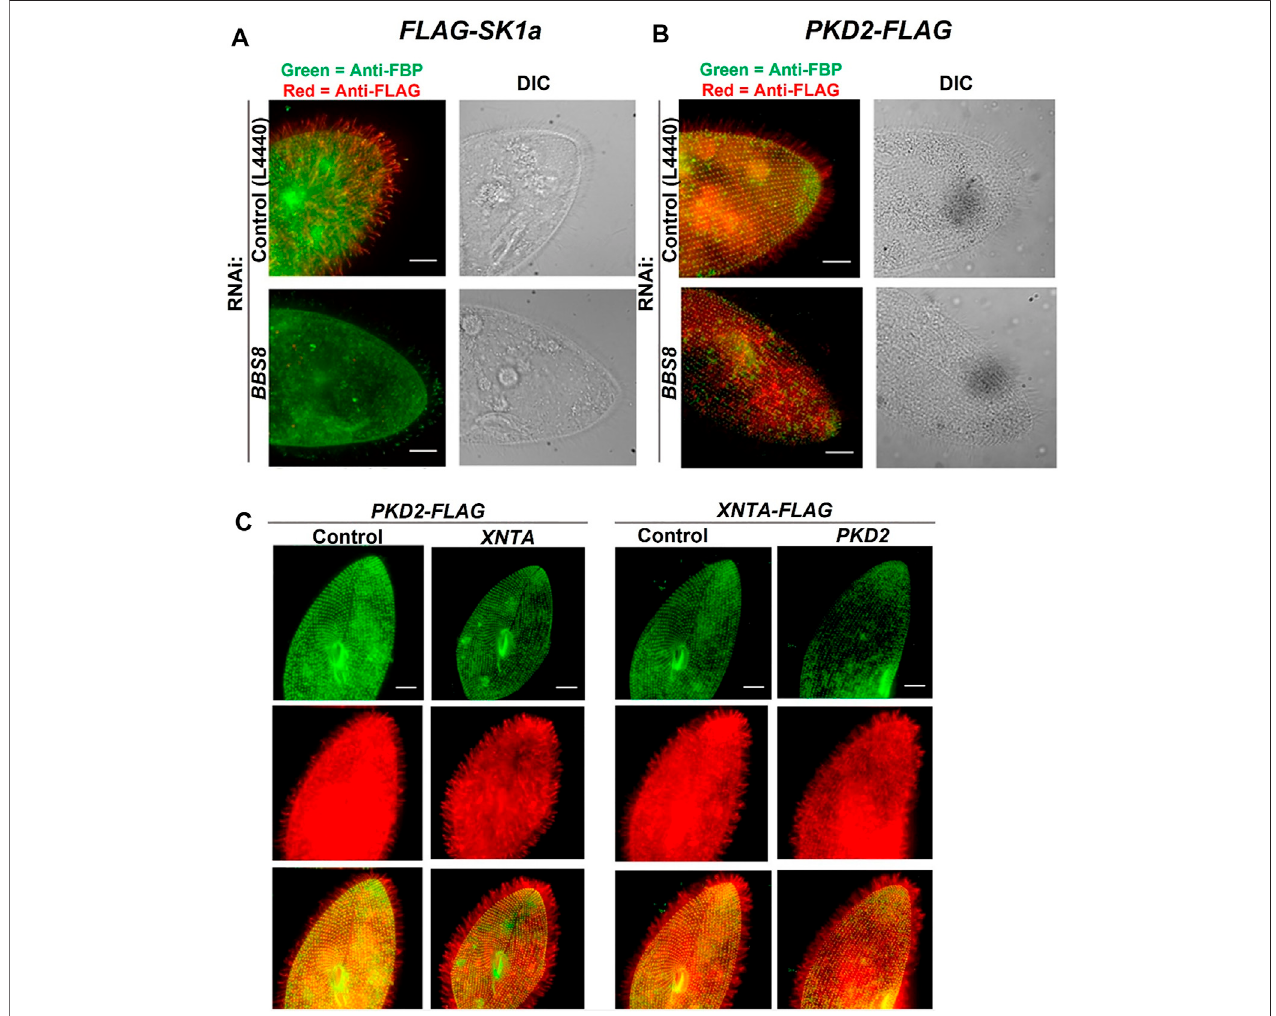
FIGURE4 | Immuno fl uorescence and RNAiallow us tofollow the locationof channels and other proteins in the cell. (A) immuno fl uorescence allowed us tolocalize theSk1achannel(FLAG-Sk1a,red)tomainlytheciliaof Paramecium (greenstainingshowstheGPI-anchoredfolatebindingprotein,FBP).Uponfeeding BBS8 RNAi,the FLAG-SK1a disappearsfromthecilia,showingthedependenceofthischannelontheBBSomefortraf fi cking.TheGPI-anchoredFBPremainsundisturbed.Similarly (B) cellsexpressing PKD2-FLAG showthePkd2channelatthecellsurfaceandinthecilia(red;basalbodiesaregreen,stainedwithanti- Tetrahymena centrin)andafter feeding the cells RNAi bacteria to deplete BBS8 , the PKD2-FLAG channel is absent from the cilia. We have also used expressing cells and RNAi to examine the dependence of interacting proteins on one another for traf fi cking (C) Cells expressing PKD2-FLAG depleted in XNTA show no change in the localization of the Pkd2 channel and visa versa; cells expressing XNTA-FLAG depleted in PKD2 show no change in the localization of the XntA protein. Scale bars represent 15 µm (A) and (B) from Valentine et al., 2012 reproduced with changes with permission using Creative Commons CC BY license (C) reproduced with permissions from Valentine et al., 2019 with permission using Creative Commons CC BY